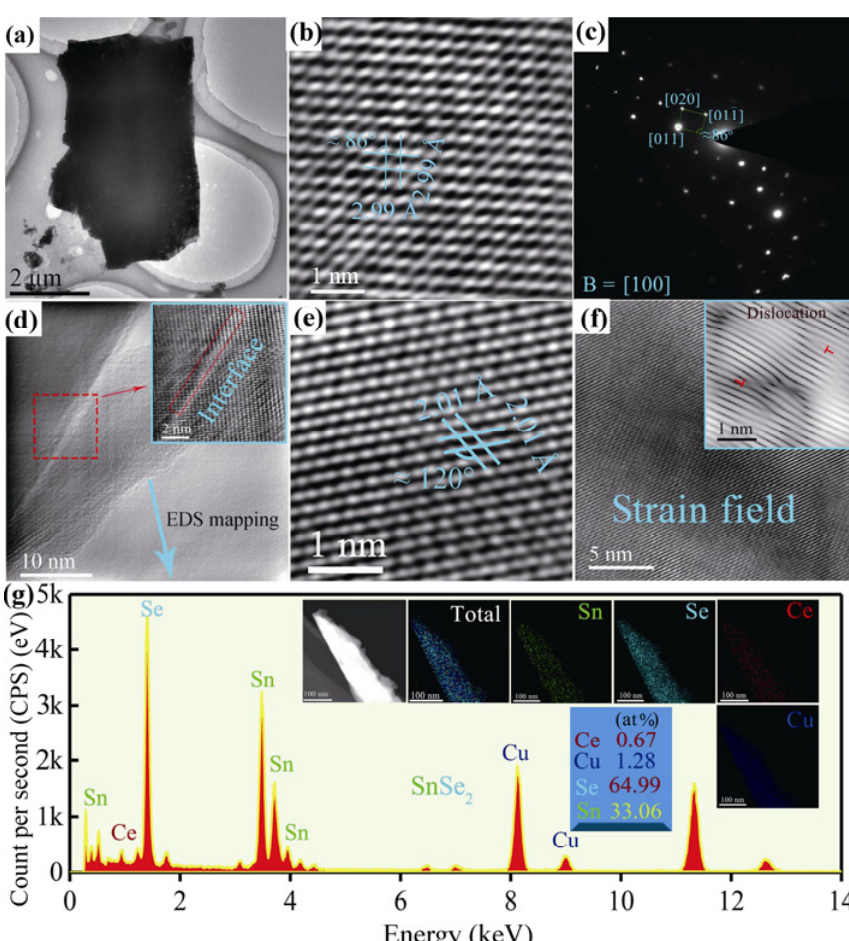
Fig. 4 (a) TEM image of typical SnSe microplate for x , y = 0; corresponding (b) HRTEM image and (c) SAED pattern taken from microplate in (a), wherein “B” in (c) is the ribbon axis. (d) TEM image of nanoprecipitation for x , y = 0.01; the inset shows magnified image of interface between Sn 0.98 Cu 0.01 Ce 0.01 Se microplate substrate and nanoprecipitation. (e) Corresponding HRTEM atomic image. (f) TEM image showing obvious strain contrast from matrix phase; the inset displays a dislocation corresponding. (g) EDS mappings taken from a